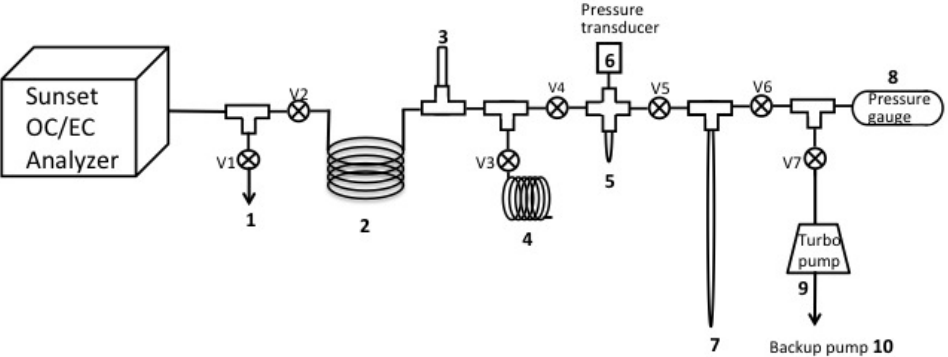
Figure 1. Sunset/Aerosol vacuum line schematic – (1) Exhaust, coming directly from the Sunset – V1 is open whenever trapping is not in progress. (2) Cryogenic trap – allows the evolving CO 2 to accumulate during the trapping procedure, while the trap is submerged in N 2 (l). (3) Safety release Pyrex tube – in case of overpressure, this is the point of pressure release. (4) Exhaust during the trapping procedure – the tightly coiled tubing reduces the risk of air flowing inward towards of the vacuum line. (5) Calibrated volume – used to measure the volume of CO 2 trapped. (6) Pressure transducer with metal port (Silicon Microsystems SM5812, 0–5psi) – monitors the pressure in the calibrated volume. (7) Pyrex break-seal tube – CO 2 is transferred here and sealed off with a torch. (8) Vacuum gauge – monitors the pressure at the end of the line (345 Pirani pressure vacuum sensor, MKS). (9) Turbo Pump (HiPace 80 Turbo-drag Pump, Pfeiffer Vacuum) and (10) Diaphragm pump (MVP 040-2, Pfeiffer Vacuum). The vacuum line is made of 1 / 8 inch OD, 0.040 inch ID stainless steal tubing and is connected to the outlet of the analyzer. Valves V1–V7 are all Swagelok SS-2P4T valves, 1 / 8 (cid:48)(cid:48) stainless